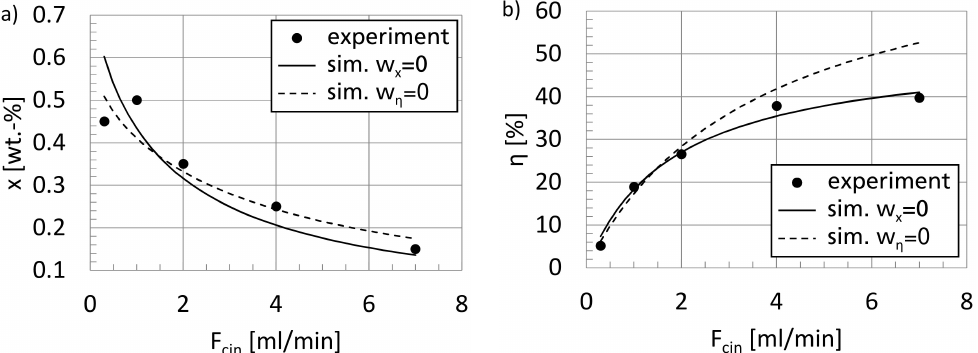
Figure 3. Comparison of the experimental values (black dots) for ( a ) the product purity x of H 2 O 2 in the outlet stream from the cathode half cell and ( b ) the Faraday efficiency η of the electrochemical reactor to their corresponding model predictions using the adjusted electro-kinetic rate constants from the solutions for the extreme compromises w x = 0 (solid line) and w η = 0 (dashed line) given in Table